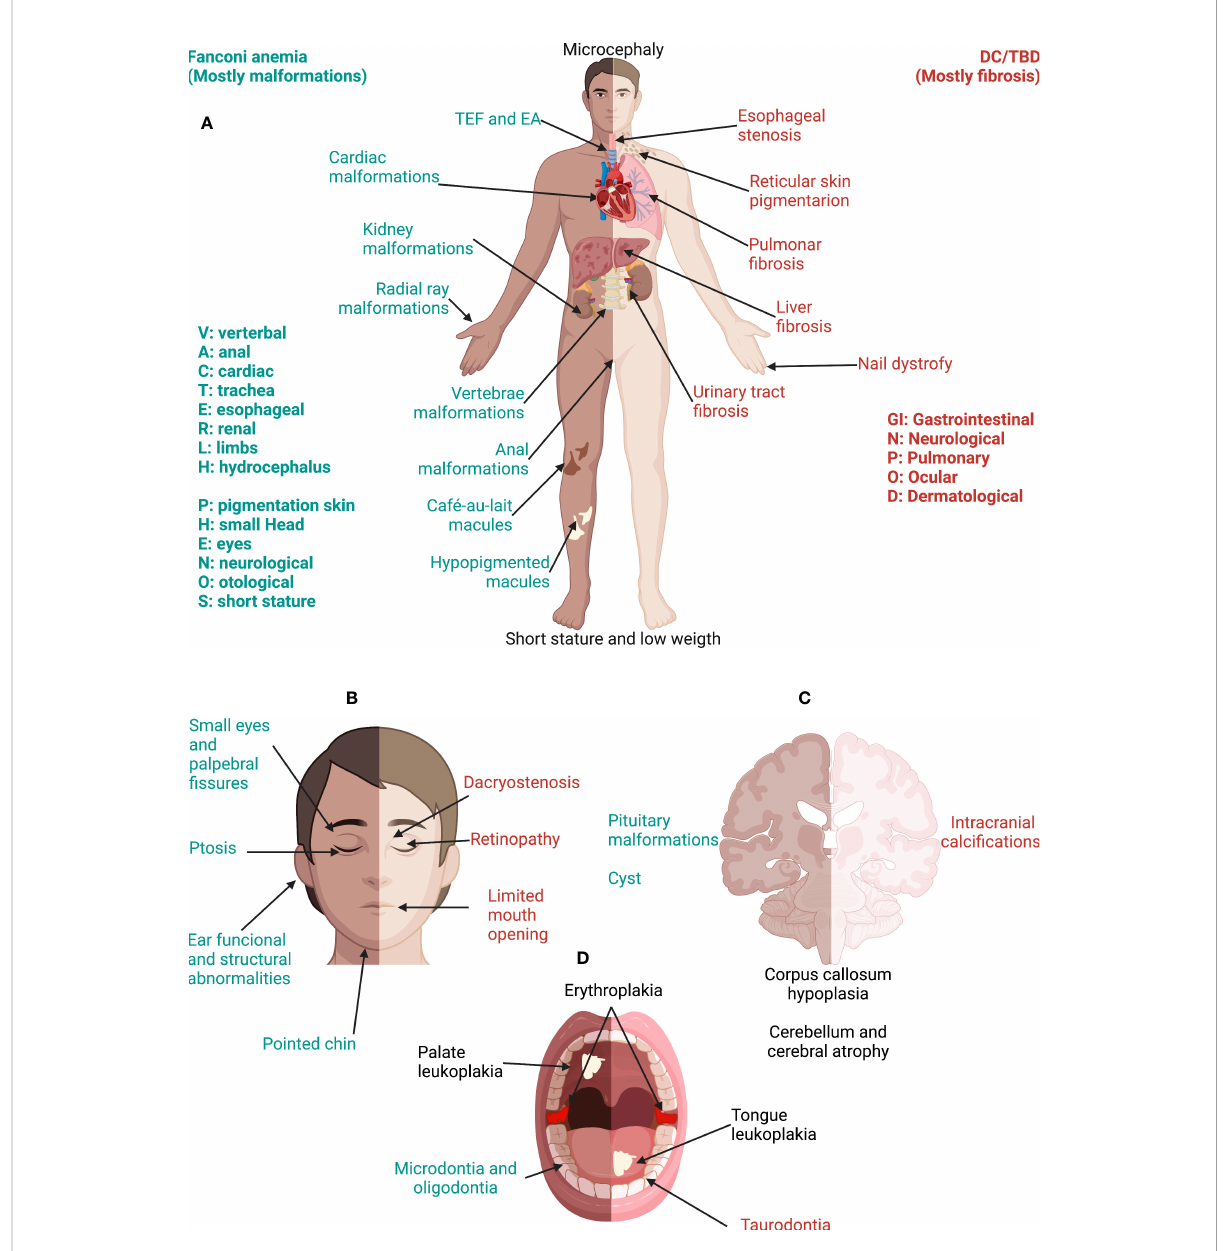
FIGURE 6 Phenotype in Fanconi anemia consists mainly in malformations whereas, in DC/TBD, it has a fi brotic nature. (A) The physical phenotype in FA is synthesized in the VACTERL-H (Vertebral, Anal, Cardiac, Tracheo-Esophageal, Renal, Limbs, Hydrocephalus) and PHENOS (Pigmentation of the skin, small Head, Eyes, Neurological, Otological, Short stature) acronyms. In DC/TBD, the physical phenotype can be informed by the GINPOD (GastroIntestinal [including liver and esophageal], Neurological, Pulmonary, Ocular, and Dermatological [including skin, nails, and leukoplakia]) acronym. GINPOD acronym includes the anomalies described in at least 20% of patients with DC/TBD. (B) Patients with FA have facial dysmorphism that integrate a recognizable FA facies: It includes small eyes and palpebral fi ssures, ptosis, and a pointed chin and can be complemented by ear abnormalities. In DC/ TBD, the more striking facial fi ndings are dacryostenosis and limited mouth opening. (C) At the nervous system level, patients with FA can have pituitary malformations and posterior fossa cysts, whereas patients with the HHS and RS, severe subtypes of DC/TBD, have calci fi cations. Both disorders may have corpus callosum abnormalities as well as cerebellum and cerebral atrophy. (D) Erythroplakia and leukoplakia are the more frequent oral fi ndings in both FA and DC/TBD; tongue leukoplakia is more frequent in DC/TBD, whereas palate leukoplakia is more frequently found in FA. Dental phenotype is contrasting as FA has microdontia and oligodontia and DC/TBD has taurodontia. Features exclusive to FA are in green, those exclusive to DC/TBD are in red, and those shared by both disorders are in black. DC/TBD, dyskeratosis congenita/Telomere biology disorders; EA, esophageal atresia; FA, Fanconi anemia; HHS, Hoyeraal-Hreidarsson; RS, Revesz syndromes; TEF, Tracheoesophageal fi